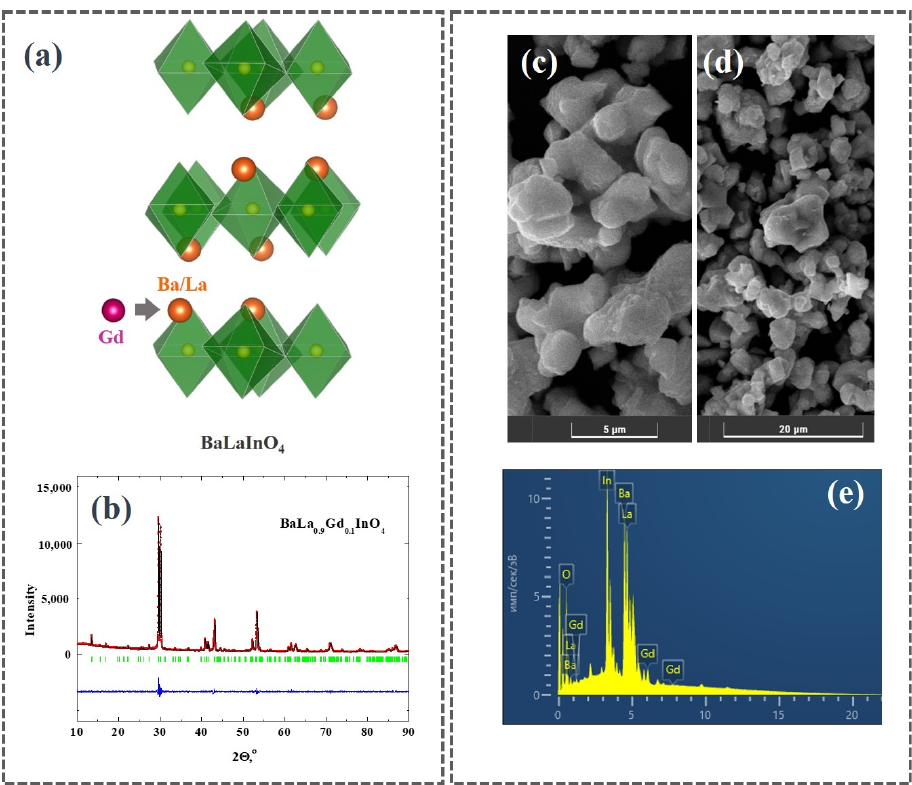
Figure 1. Scheme of gadolinium doping of BaLaInO 4 :( a ), XRD ‐ patterns (red dots are experimental data, black line is the theoretical fitting, blue line is the difference between the experimental and the calculated one after refinement, vertical green bars are Bragg angle positions) ( b ), SEM ‐ images ( c ), ( d ) and EDS ‐ spectrum ( e ) of BaLa 0.9 Gd 0.1 InO 4 composition.